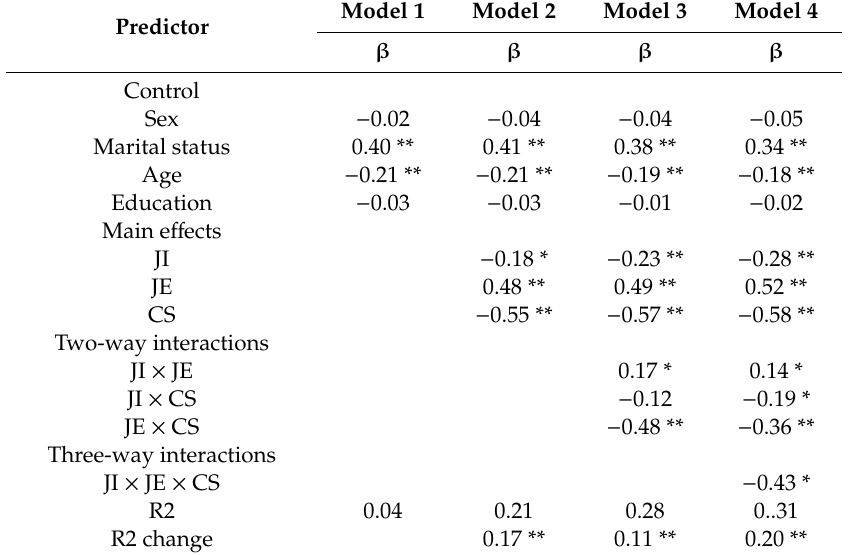
Table 2. Results for moderated multiple hierarchical regression analyses for life